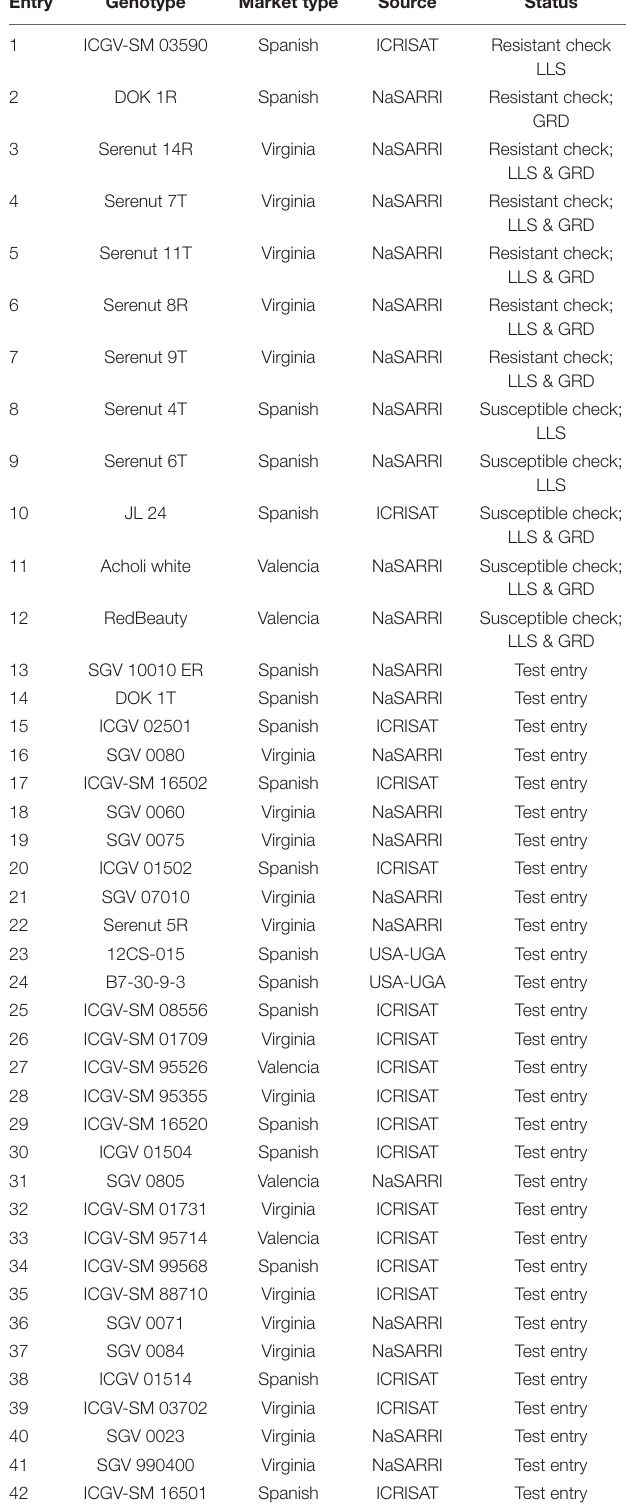
TABLE 1 | A list of genotypes used in the study showing their market type, source, and